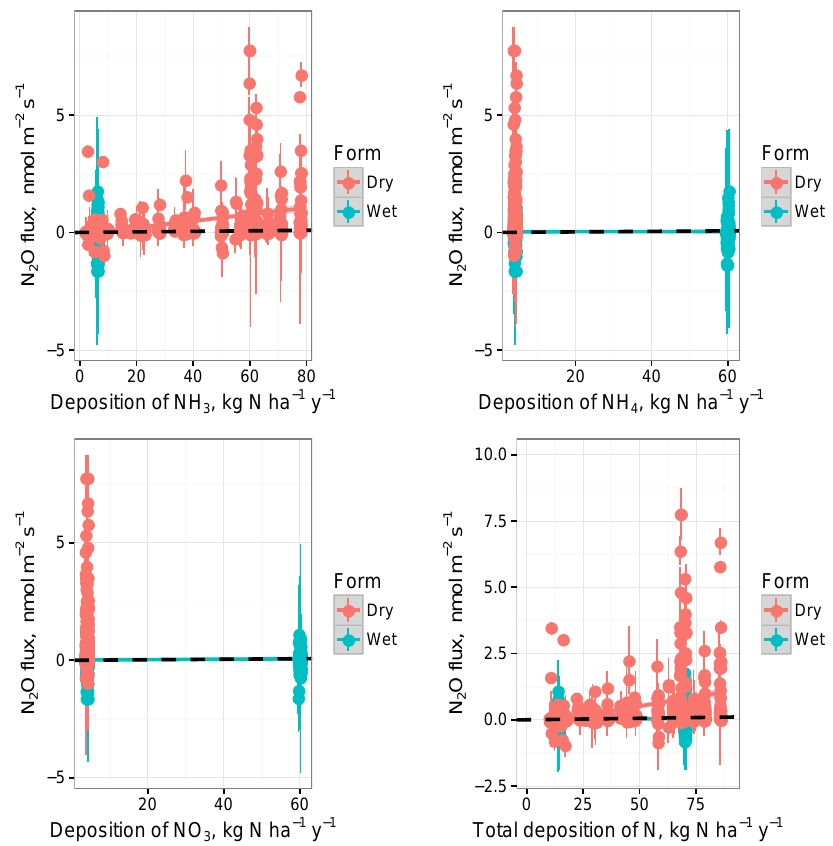
Figure 3. Response of N 2 O flux to deposition of NH 3 , NH + based on the regression slope for each flux measurement. Solid lines show the fitted response from the general additive mixed model. Dotted lines show the emission predicted with the IPCC default emission factor, as 1% of the deposited